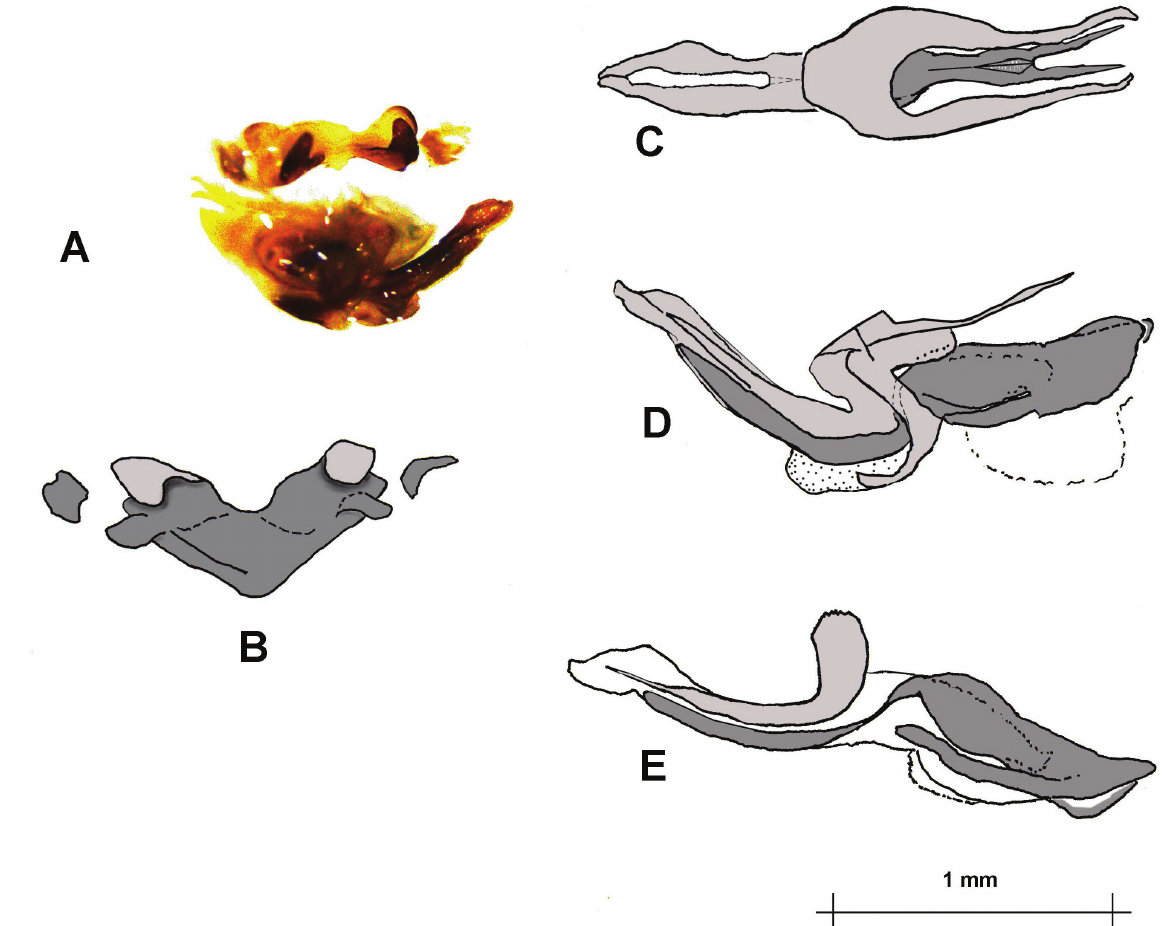
Fig. 6. Mopla guttata , phallic structures. A . Oblique posterior view of phallic complex before preparation and dissection; B. Epiphallus, anterior view; C. Dorsal and D. Lateral views of phallic complex with epiphallus, epiphallic, and ectophallic membranes removed; and E. Endophallus, arch sclerite, and ectophallic aedeagal valves, after removal of remaining ectophallic structures. In C–E the endophallus is in a darker shading, the ectophallus in lighter shading. The broken line in D indicates the presumed position of the ejaculatory sac, missing from this preparation. Spermatophore sac